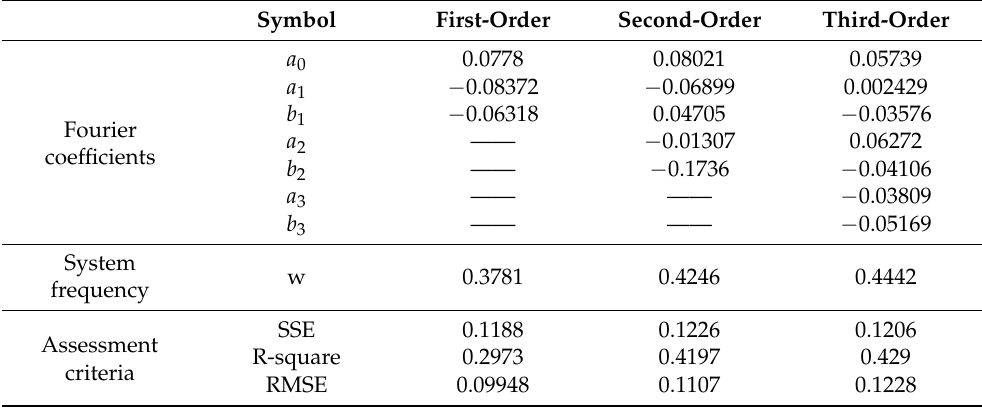
Table 5. Fourier coefficients and different types of fitting errors considering various orders of Fourier series for stress leveling of 5 MPa.